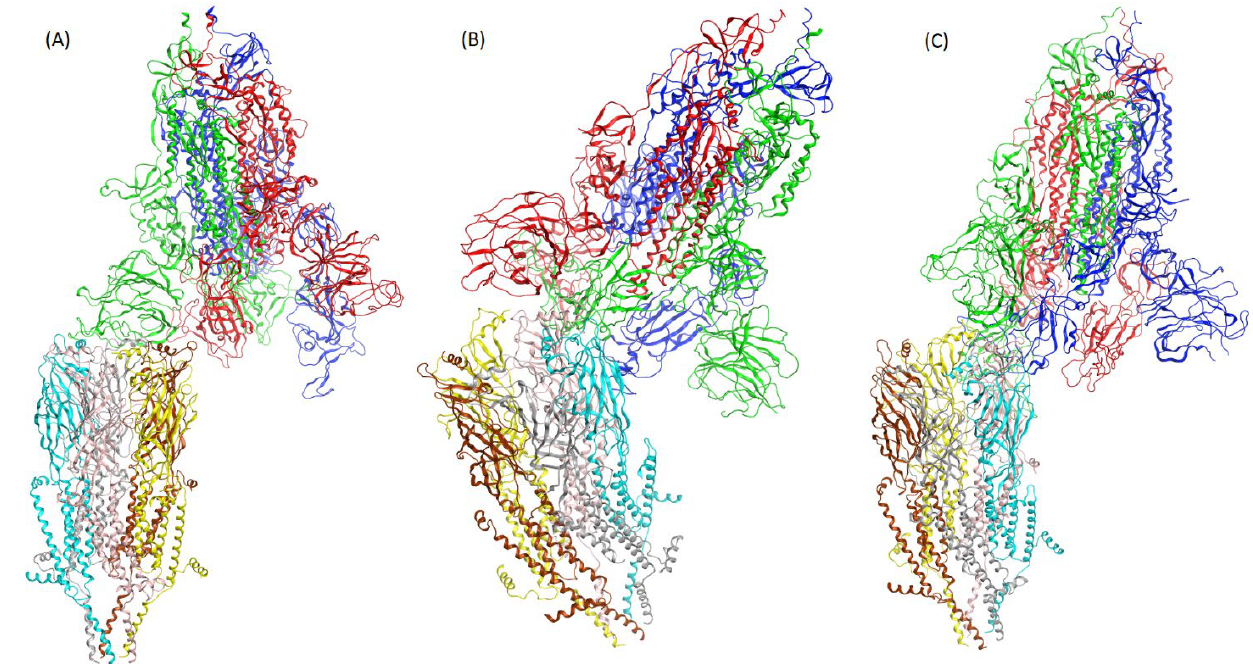
Figure 2. α 7 appears in the bottom region in complex with the ( A ) main spike, ( B ) Delta, and ( C ) Omicron variants of spike protein on top; Spike protein trimer is colored in dark blue (chain A), red (chain B), and green (chain C). The α 7nAChr pentamer is colored in cyan (chain A), pink (chain B), yellow (chain C), brown (chain D), and gray (chain E). In ( A ), the chain B (pink) and chain C (yellow) monomers of the α7nAChr are interacting with the chain A (dark blue) and chain B (red) monomers of the main spike protein. In ( B ), the chain B (pink) and chain C (yellow) monomers of the α7nAChr are interacting with the chain C (green) and chain B (red) monomers of the Delta variant of spike protein. In ( C ), the chain B (pink) and chain C (yellow) parts of the α7nAChr are interacting with the chain A (dark blue) and chain C (green) monomers from the omicron variant of spike protein. Table 5. The energy state of the bond between the α7nAChr and (A) main spike, (B) Delta, and (C) Omicron variants of spike protein. The explanation of each energy feature in the first row is de- scribed in Table 2.